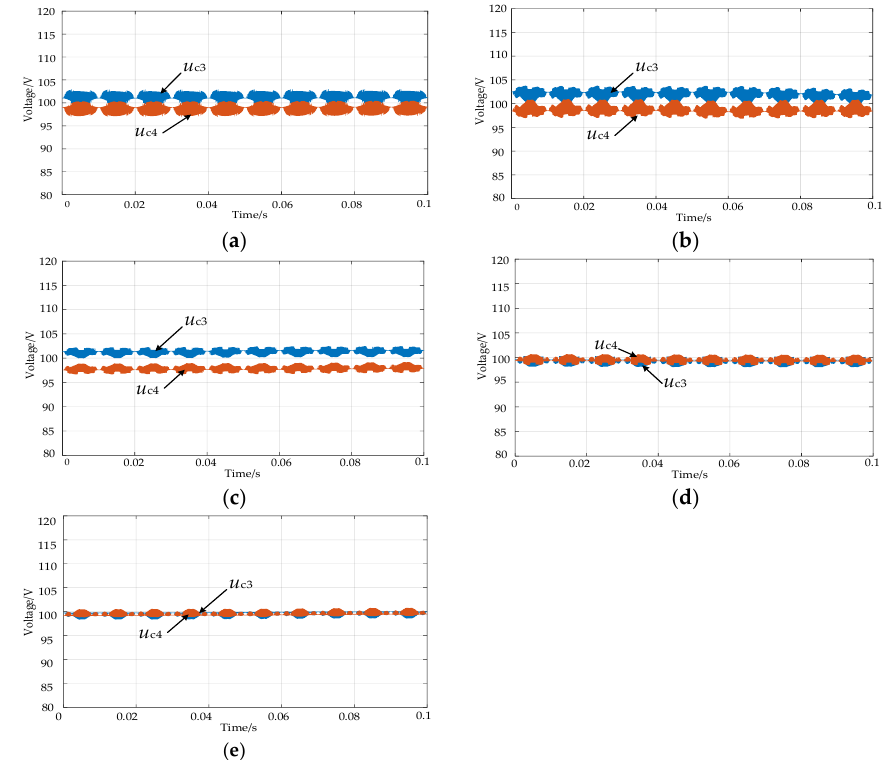
Figure 10. The voltages of u c3 and u c4 under different modulation methods during steady - state operation. ( a ) SPWM. ( b ) SVPWM - 1. ( c ) SVPWM - 2. ( d ) SVPWM - 3. ( e ) SVPWM - 4(hybrid).